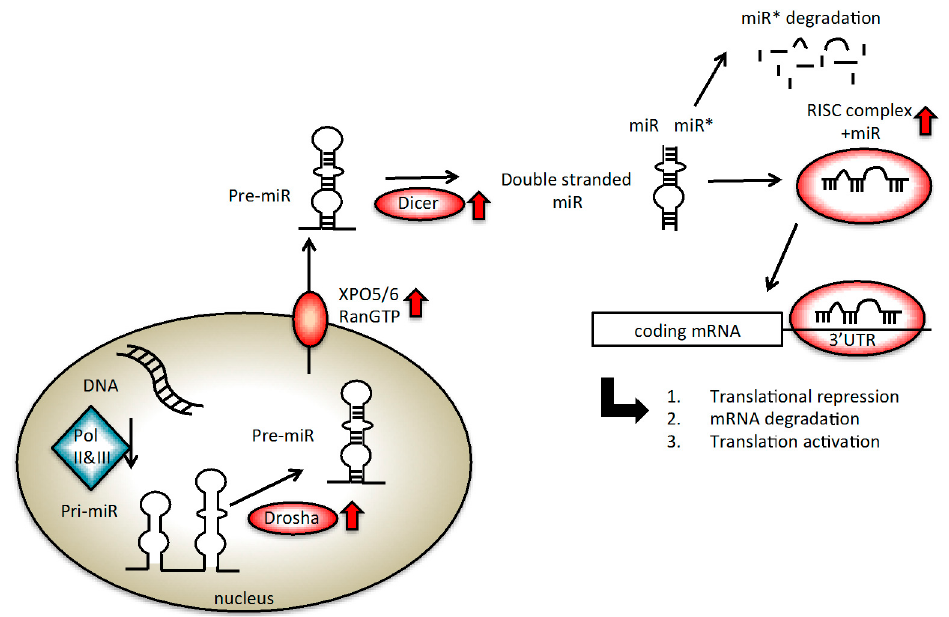
Figure 1. miRNA biogenesis. Red arrows indicate steps altered in prostate cancer (PC). The standard steps of the biogenesis are indicated with the black arrows. miRNAs are transcribed by RNA Polymerase (Pol) II or III to generate initially a sequence, called pri-miRNA, of approximately 200 bp. Afterwards, Drosha RNase III cleaves the pri-miRNA into a 100 nt sequence, called pre-miRNA, which is then exported out of the nucleus by exportin 5/6 (XPO5/6) and RanGTP. Another RNAse III, Dicer, generates a double stranded miRNA containing a miRNA/miRNA* duplex. The mature miRNA is loaded into the RNA-induced silencing complex (RISC) complex. The complementarity of the sequence between the miRNA and the mRNA leads either to translational repression if matching is imperfect, mRNA degradation if the seed is completely recognized, or translational activation, which occurs less frequently.